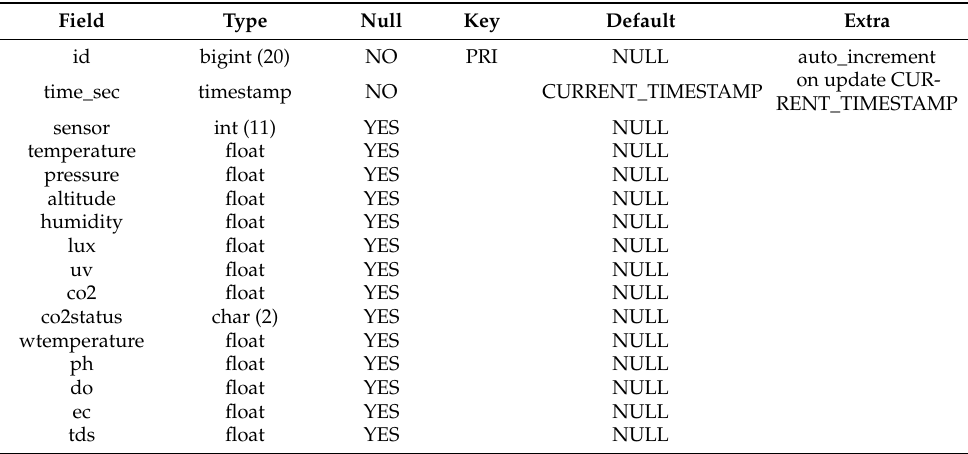
Figure 3. Nano-sized private AI-Cloud for the functions of analysis station module. Table 3. The sensors table schema in the growing_environment database.